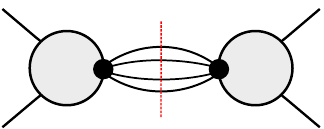
Figure 23: A graph with a 4-legged bubble has a 4-particle cut on one channel. How- ever, there is no space left for a cut on the other